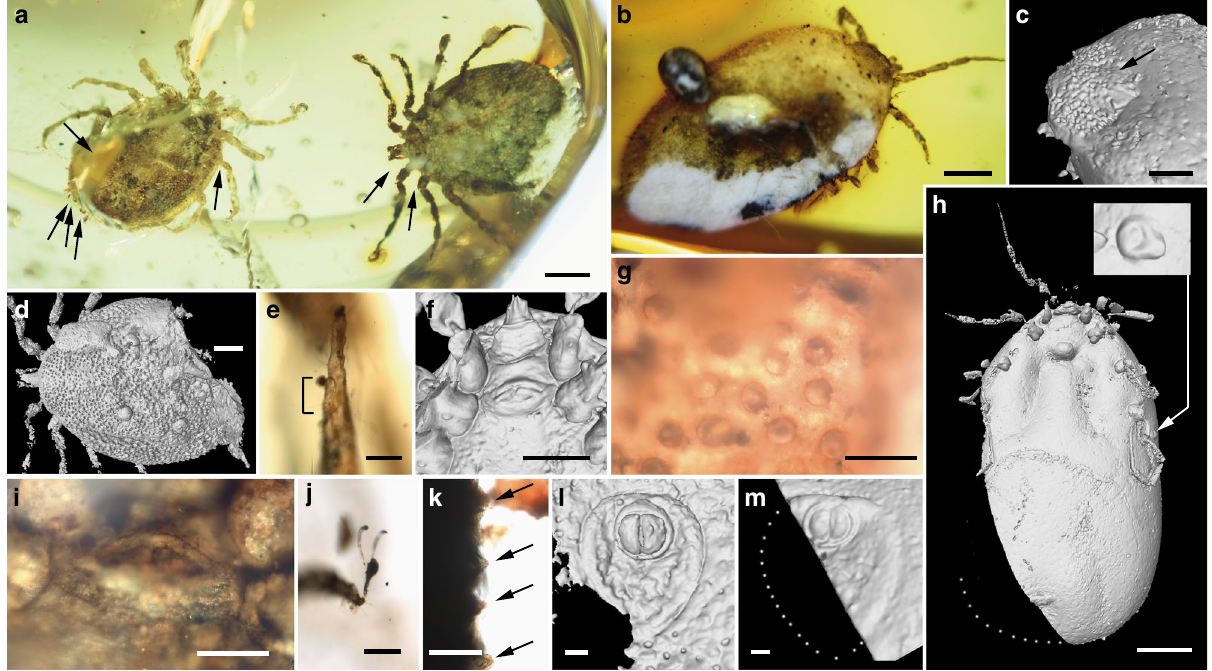
Fig. 3 Morphology of the new tick family Deinocrotonidae. a Holotype (left) and paratype male in ventral view (arrows indicate the location of some entangled hastisetae of the beetle family Dermestidae). Scale bar, 1 mm. b Engorged paratype female in dorsolateral view. Scale bar, 1 mm. c Pseudoscutum (arrow) of specimen in b . Scale bar, 0.5 mm. d Paratype male in dorsal view. Scale bar, 0.5 mm. e Dorsal surface of the tarsus I from the holotype, showing Haller ’ s organ, an aggregate of chemoreceptors, mechanoreceptors, and hygroreceptors in ticks for locating hosts and mates (lines mark the length of the organ). Scale bar, 0.1 mm. f Transverse genital aperture between coxae II, coxal spurs, and basis capituli from the holotype. Scale bar, 0.5 mm. g Pitted dorsal integument without elevations in the pseudoscutum of the same specimen. Scale bar, 0.1 mm. h Engorged paratype female in ventral view with detail of the spiracle. Scale bar, 1 mm. i Genital aperture between coxae II of the paratype male. Scale bar, 0.2 mm. j Pulvillus and pretarsal claws of the holotype.